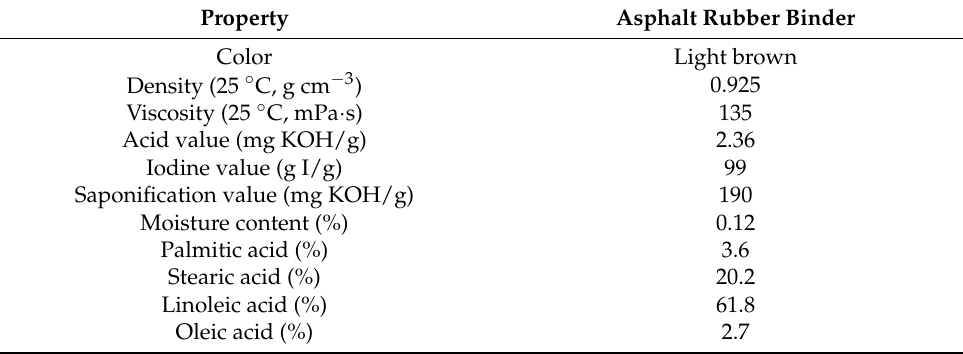
Table 6. Physical property and chemical constitution of WCO.